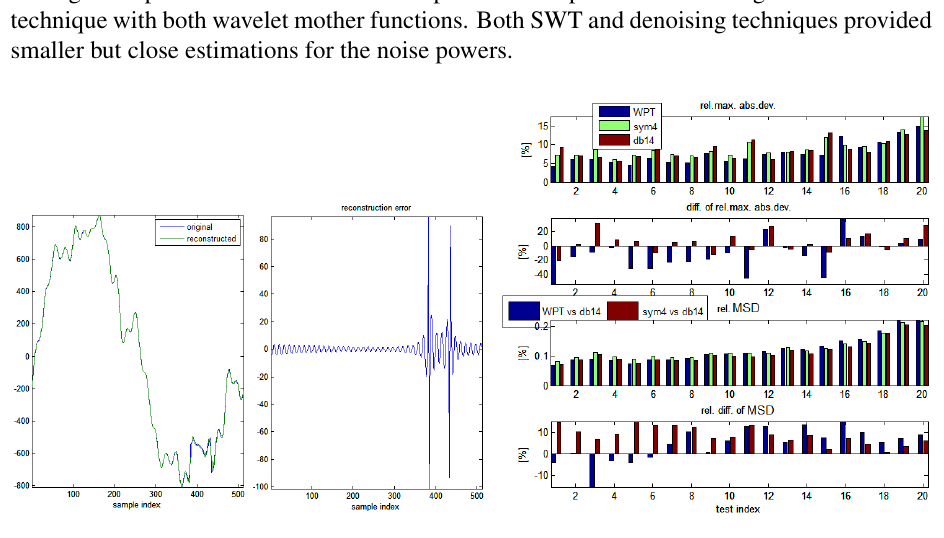
Figure 15. Original and reconstructed signal, af- ter WPT decomposition (left) and reconstruction error (right), for the 2-nd set of data.